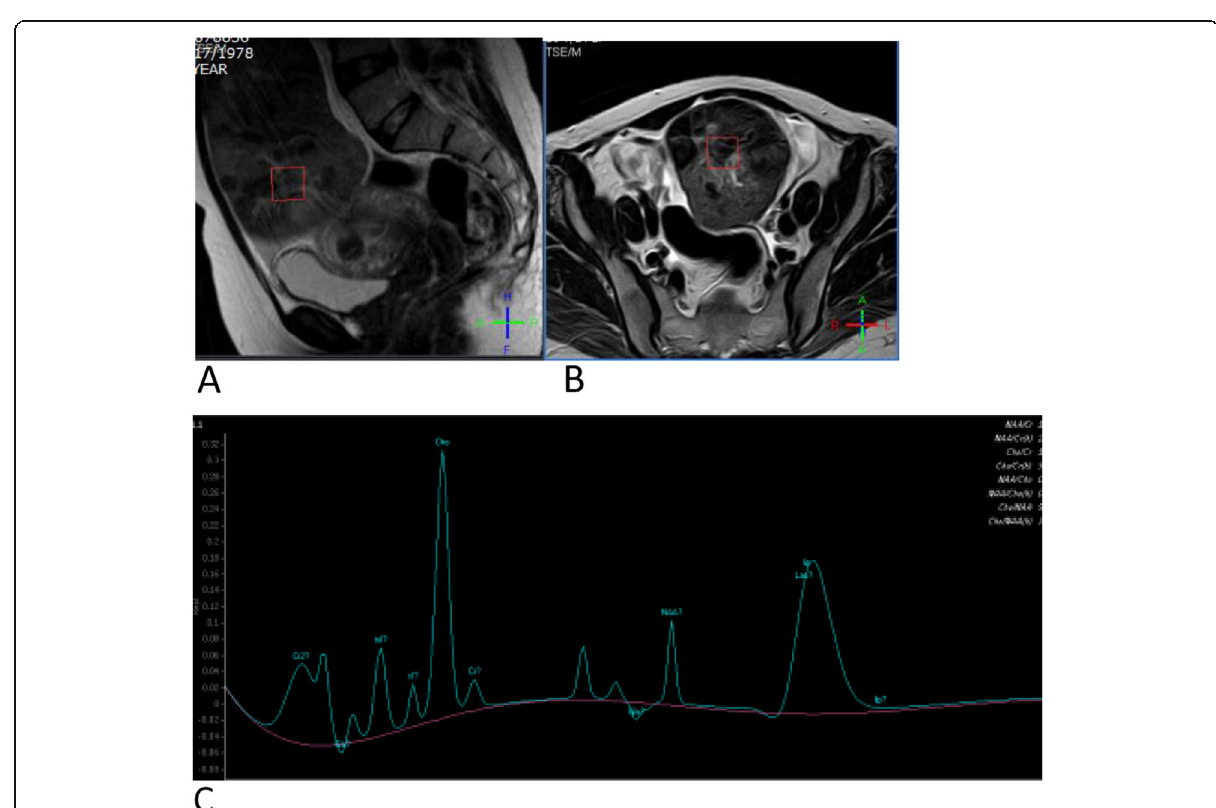
Fig. 1 A 39-year-old female patient with left ovarian fibrothecoma. a . Sagittal T2-weighted image showing solid mass isointense to the myometrium, with voxel in its center. b . Axial T2-weighted image with solid mass with voxel in its center. Mild ascites is noted. c MR spectroscopy shows high choline peak at 3.23 ppm with Cho/Cr ratio 10.3. Peaks of NAA and lipid are also